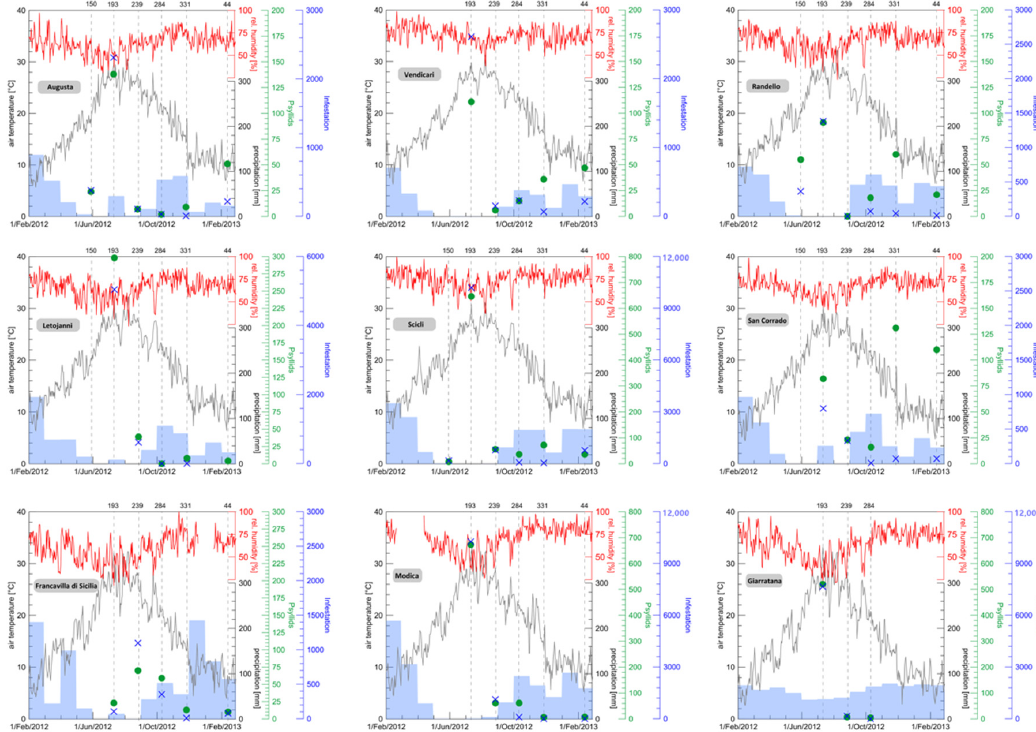
Figure 2. Biological data deriving from the “psyllids sampling” (green dots) and the “infestation sampling” (blue crosses) (given on the secondary axis on the right) correlated to the daily mean values of air temperature and relative humidity and the daily totals of precipitation for the nine test sites. Time range: 01/02/2012–28/02/2013. Rstudio version 1.2.5001 with R version 4.0.2 patched was used in testing for significant